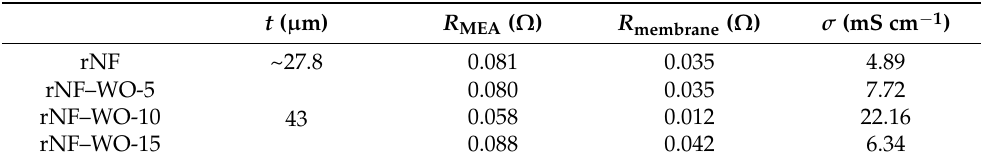
Table 1. Membrane thickness (t), resistance (R), and proton conductivity ( σ ) values of recast Nafion and hybrid membranes at 25 °C and 100% RH.